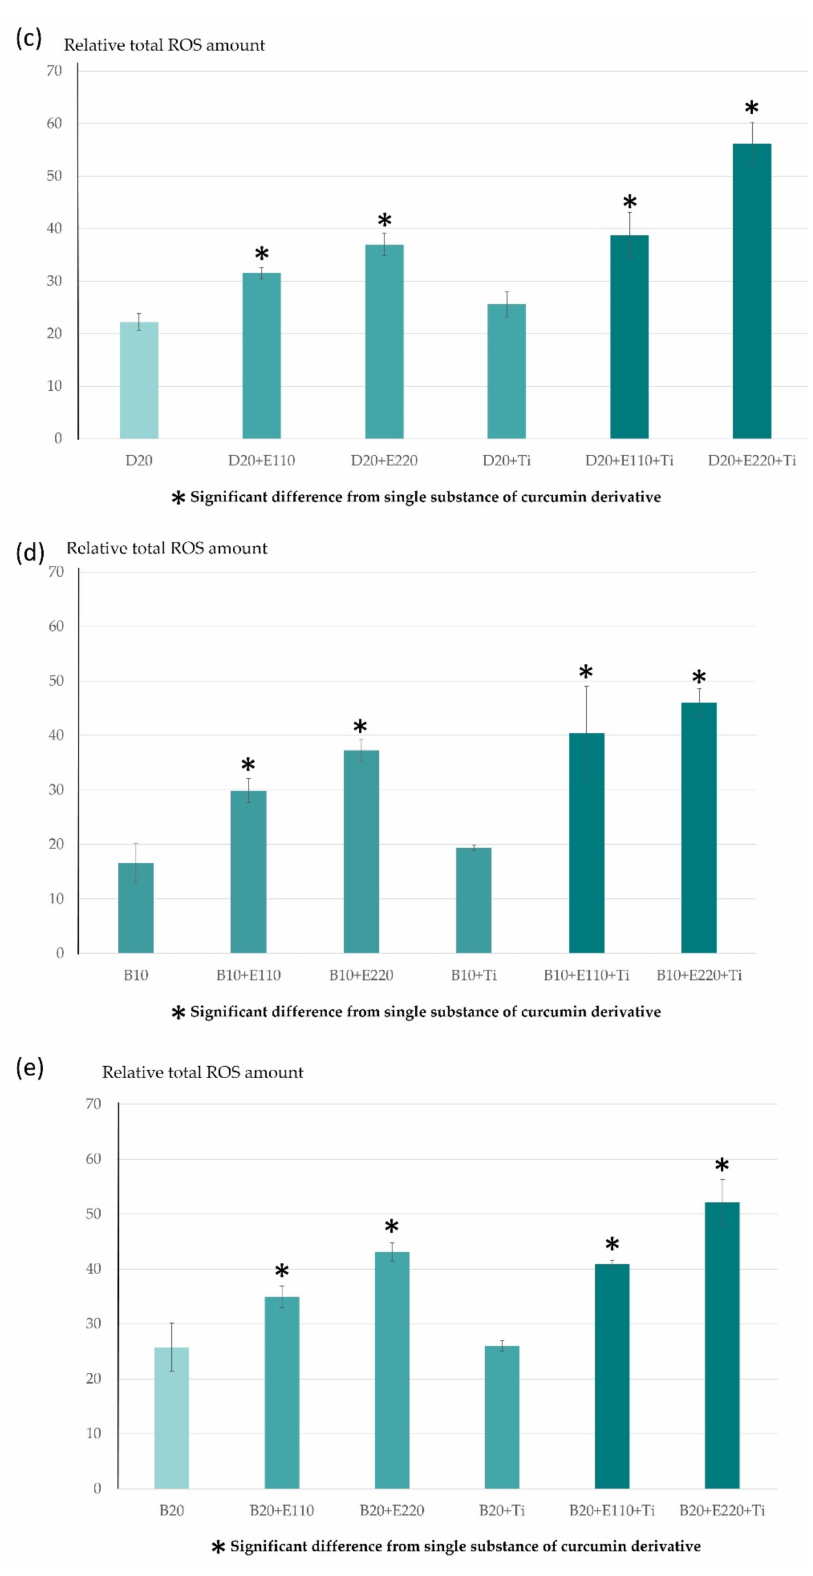
Figure 1. Total ROS formation of the test photosensitizer preparations used in photodynamic therapies with dental blue light optics (72 J/cm 2 ) using ESR spectroscopy and TEMPO as a spin probe. ( a ) All test photosensitizers; ( b ) 10 µ M demethoxycurcumin and its combination; ( c ) 20 µ M demethoxycurcumin and its combination; ( d ) 10 µ M bisdemethoxycurcumin and its combinations; ( e ) 20 µ M bisdemethoxycurcumin and its